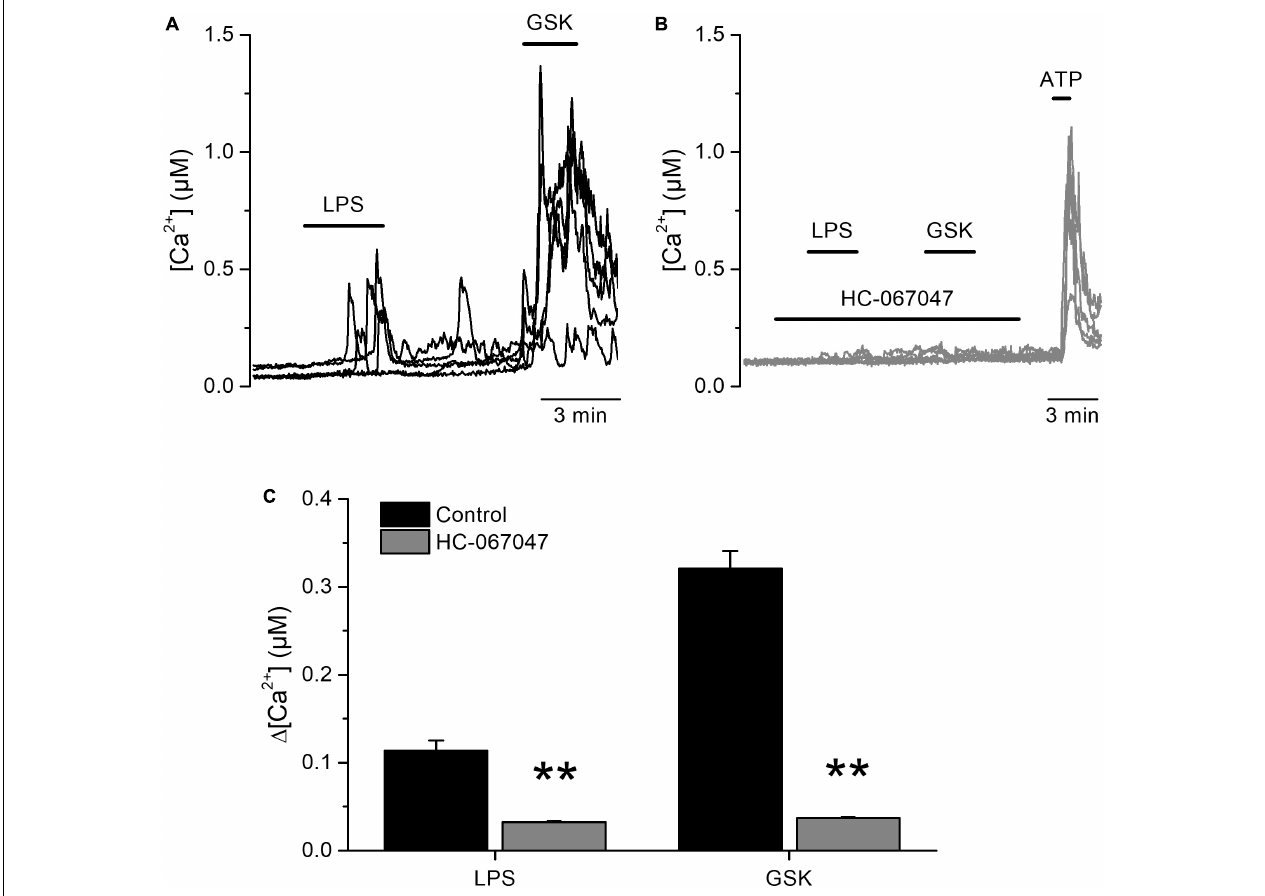
FIGURE 1 | Acute TRPV4-dependent stimulation of human urothelial cells by E. coli LPS. (A,B) Representative traces of intracellular Ca 2 + signals recorded in human UCs. LPS (20 µ g/ml) and GSK1016790A (GSK, 10 nM) were perfused in control (A) , or in the presence of the TRPV4 inhibitor HC-067047 (10 µ M) (B) . ATP (100 µ M) was applied at the end of the latter experiments to assess cellular responsiveness. (C) Average amplitudes of intracellular Ca 2 + responses evoked by LPS (20 µ g/ml) or GSK1016790A (GSK, 10 nM) in the absence ( n = 173) of presence ( n = 280) of HC-067047 (10 µ M). ** P < 0.01, Mann–Whitney U